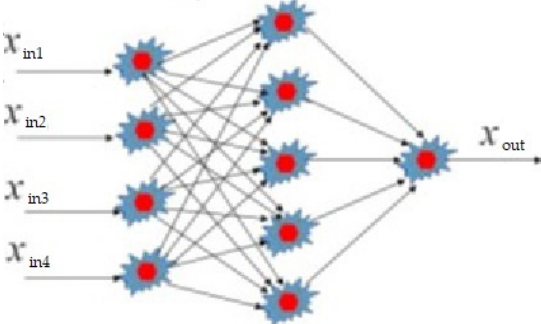
Figure 5. One example of an artificial neural network.